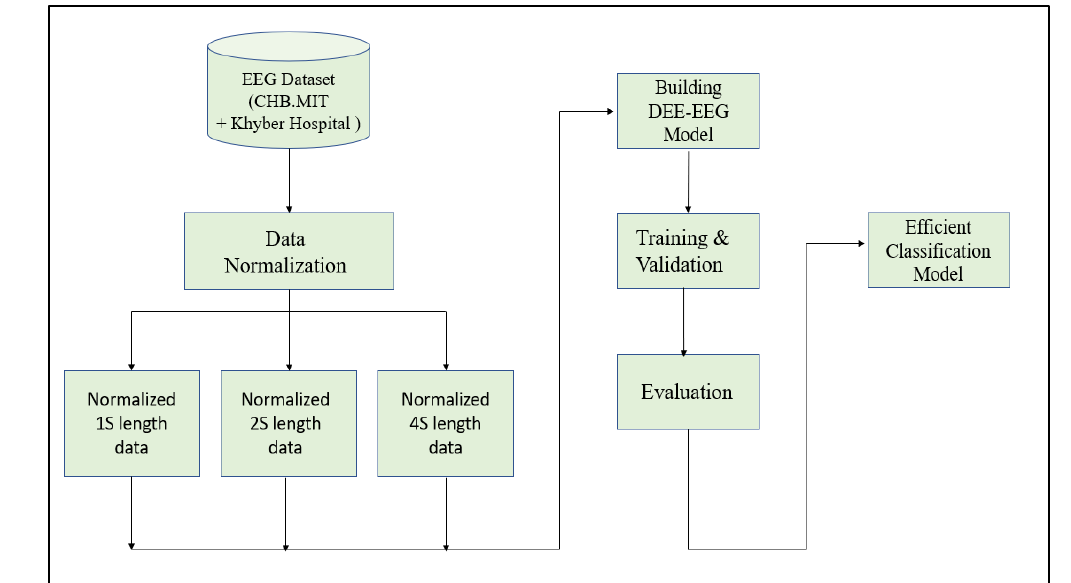
Figure 2. The flow diagram of the adopted methodology.